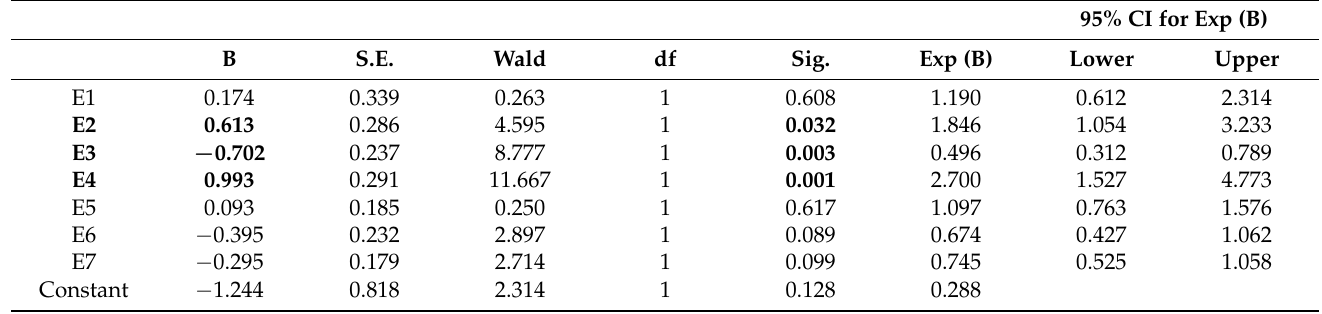
Table 17. Results of logistic regression analysis of length of visit to the